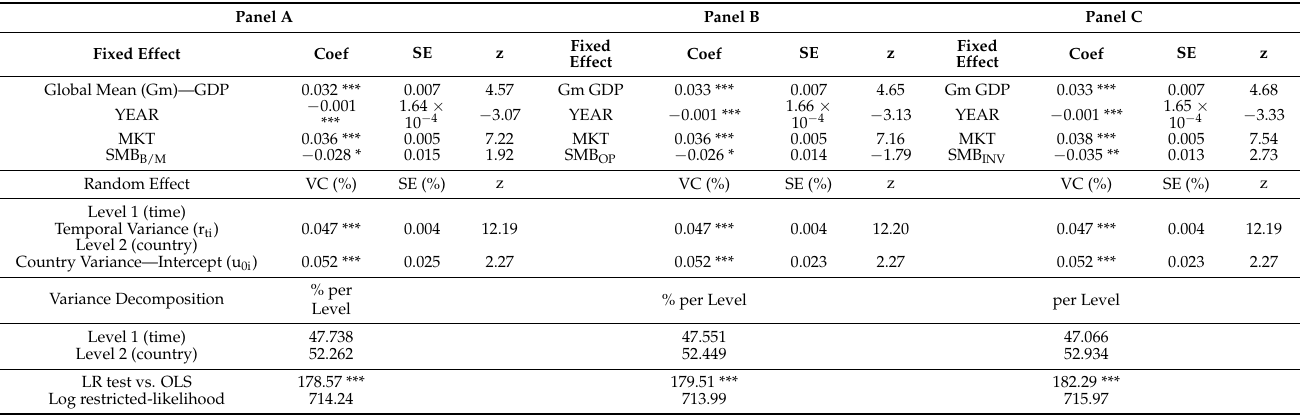
Table 12. Decomposition of variance—Linear Trend Model with Random Intercepts and Explanatory Variables that Capture Level 2 Random Effects—Final Complete